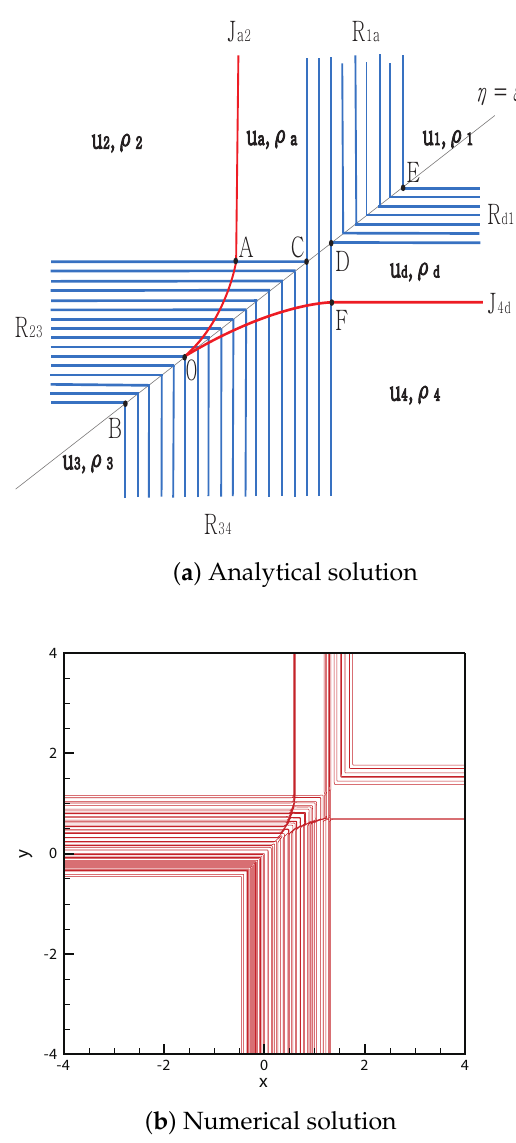
Figure 5. Case 3. RJ + R + R +